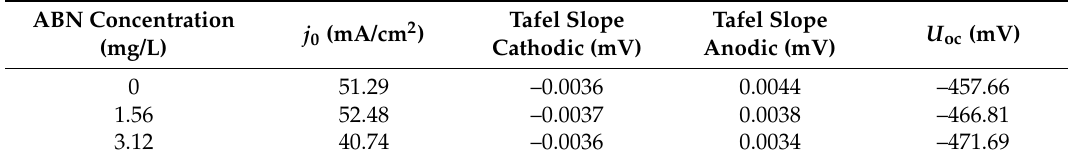
Table 4. Influence of the ABN concentration on the kinetics parameters in the MSA citrate-free electrolyte.